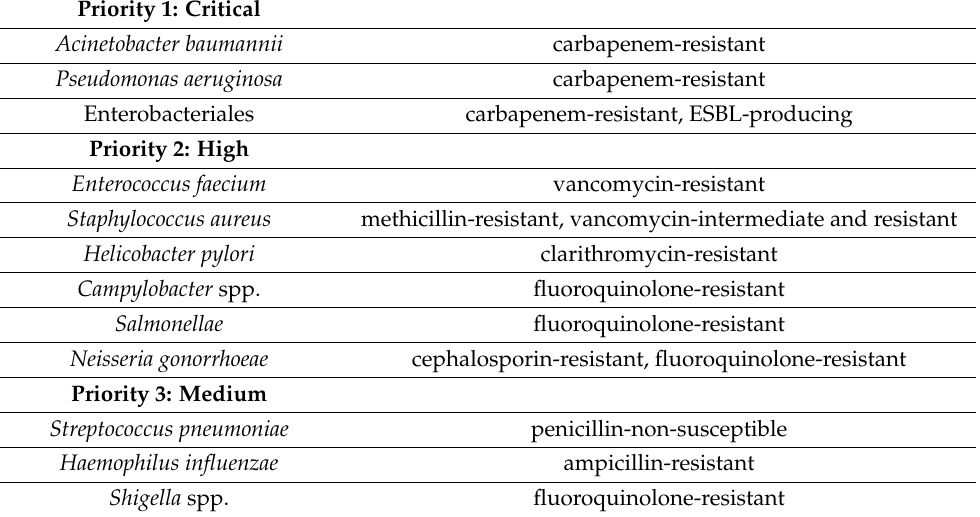
Table 1. WHO priority bacterial pathogens and their clinically relevant antibiotic resistance phe- notypes which render treatment problems (adapted from www.who.int (accessed on 21 June 2021) and [7]). ESBL: extended spectrum